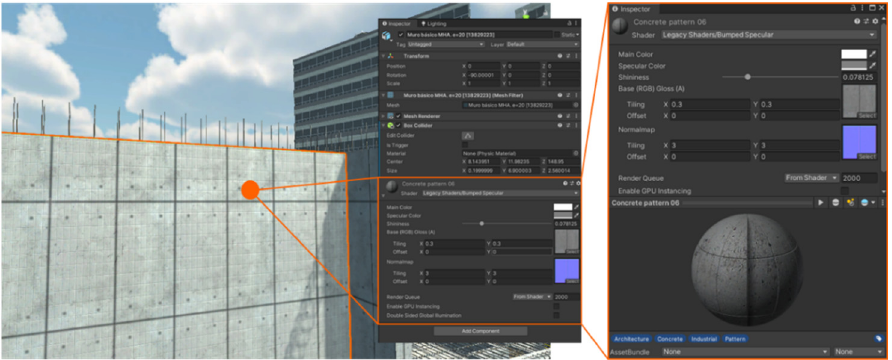
Figure 7. Selection of materials in Unity3D ® (Unity Technologies, San Francisco, CA, USA) with their corresponding textures.